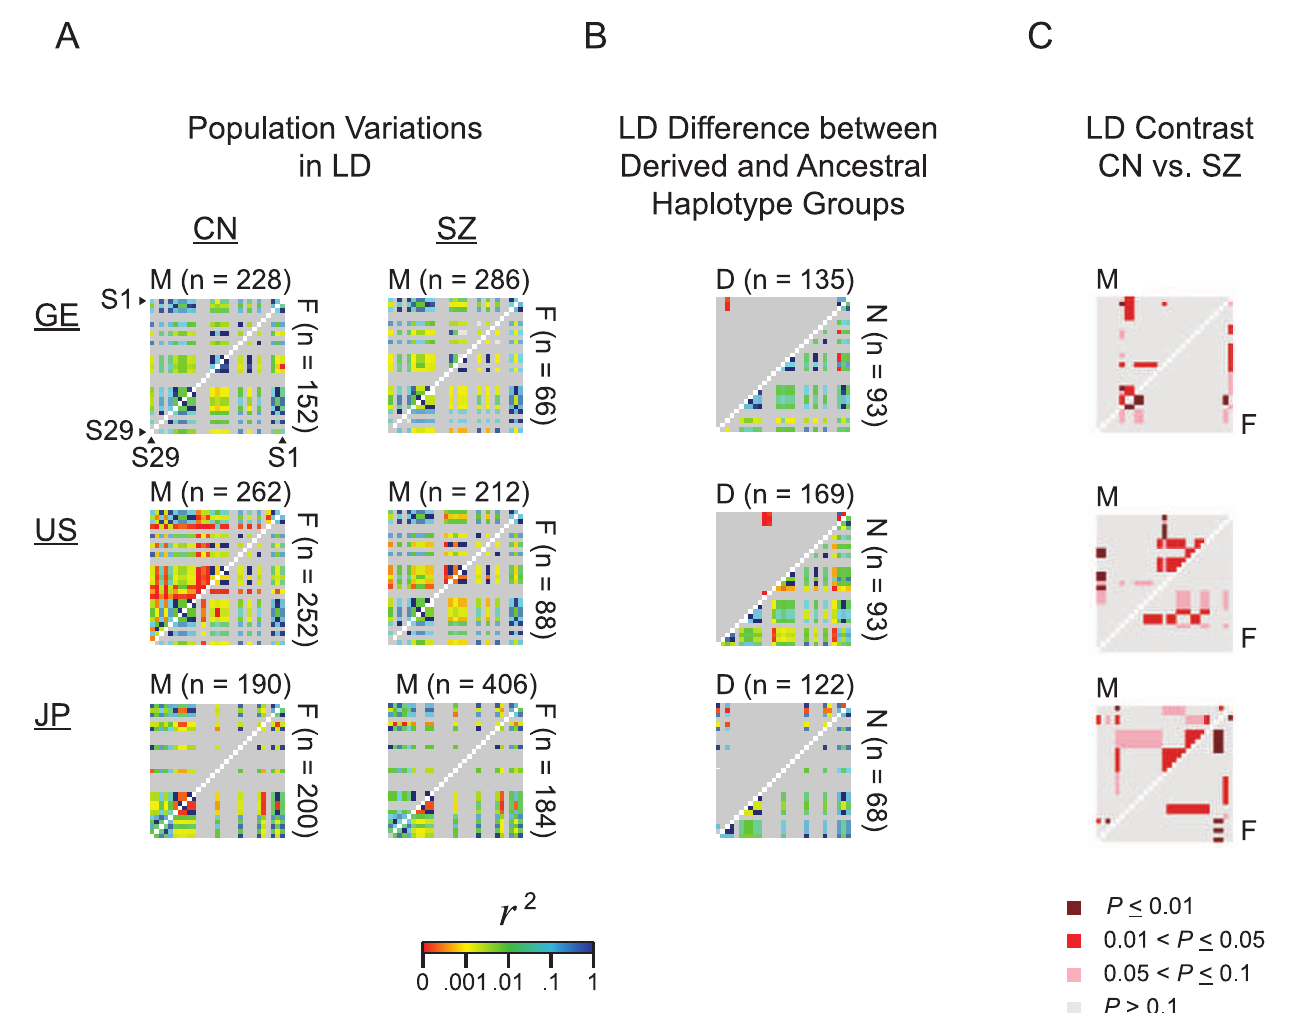
Figure 4. Linkage disequilibrium (LD) analysis. (A) Detection of recombination in LD-plots. Haplotype forms were inferred from genotype data of the samples using PHASE version 2.1. One thousand resamplings were performed for the haplotype set of each cohort. Different haplotype forms are shown in Table S2. Coefficients of LD ( r 2 ) estimated by DnaSP [43] for each SNP pair (Table S5) are displayed in thermal scale (shown at bottom of figure) for available male (M, upper triangles) and female (F, lower triangles) CN and SZ samples in GE, US and JP populations. (B) LD-plots for derived (D) and ancestral (N) haplotypes for GE, US and JP Males in same thermal scale, with D- and N-haplotypes being distinguished based on the allelic form of S5 contained in the haplotype (Table S6). (C) LDcontrast [44] between CN and SZ derived from the corresponding CN and SZ plots for GE, US and JP groups from part (A). The P values pertaining to the CN versus SZ comparisons (Table S7) are plotted for M (upper triangles) and F (lower triangles) cohorts in color-coded ranges as shown below the plots: significant CN-SZ difference is indicated by a red (for 0.01 , P # 0.05) or dark red (for P # 0.01) square for each CN-SZ comparison.